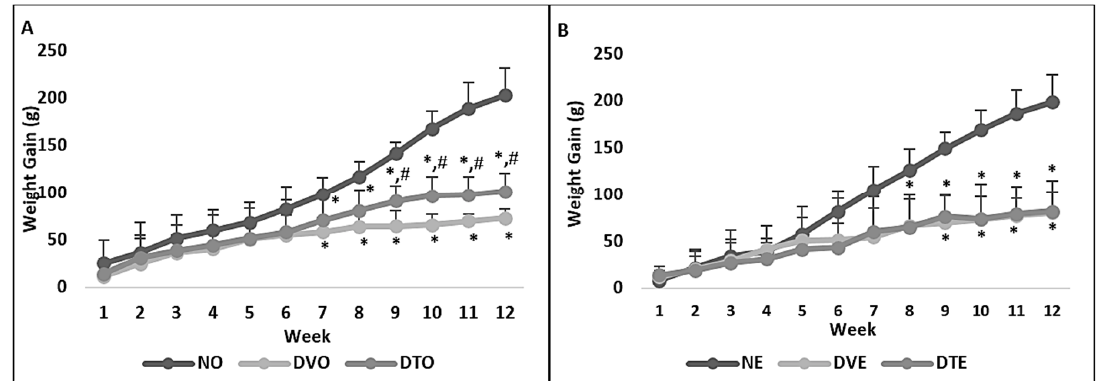
Figure 1. Weight gain (grams) among various groups of rats that received treatment ( A ) orally and ( B ) topically over 12 weeks of the experimental period. NO: Normal rats with oral vehicle treatment, DVO: Diabetic rats with oral vehicle treatment, DTO: Diabetic rats with oral TRF treatment, n = 6, * p < 0.05 versus NO or NE; # p < 0.05 versus DVO. NE: Normal rats with topical vehicle treatment, DVE: Diabetic rats with topical vehicle treatment, DTE: Diabetic rats with topical TRF treatment, n = 6.